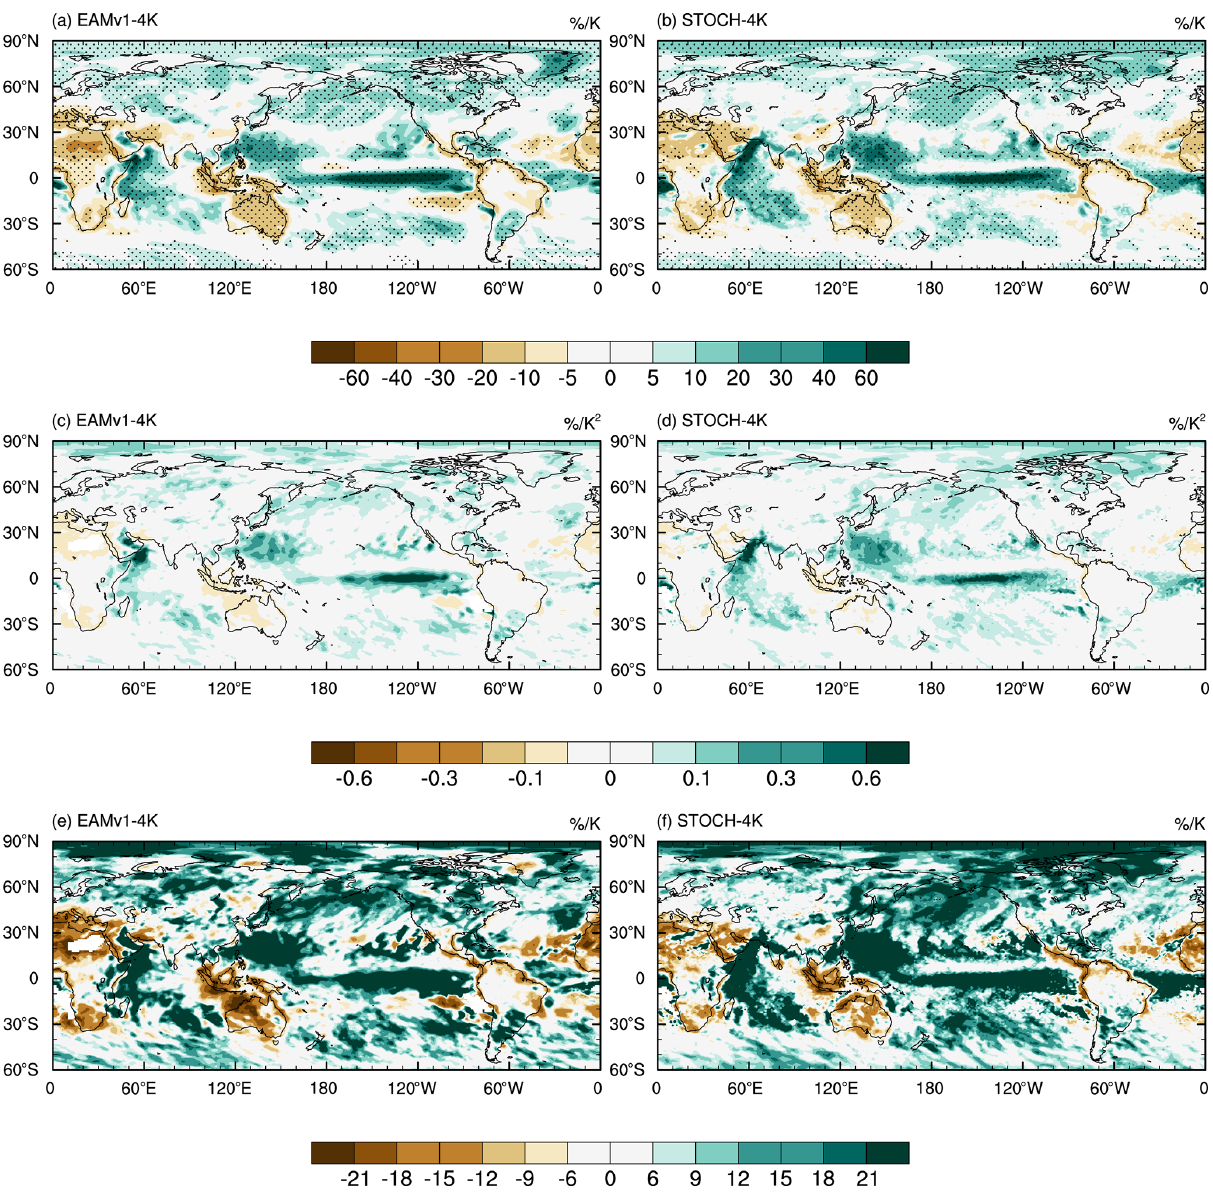
Figure 14. Geographical distributions of the responses of (a, b) annual mean precipitation, (c, d) the coefficient a and (e, f) the fractional change in precipitation extremes (R95p) to climate warming from + 4K experiments. Differences with a confidence level greater than 95% are